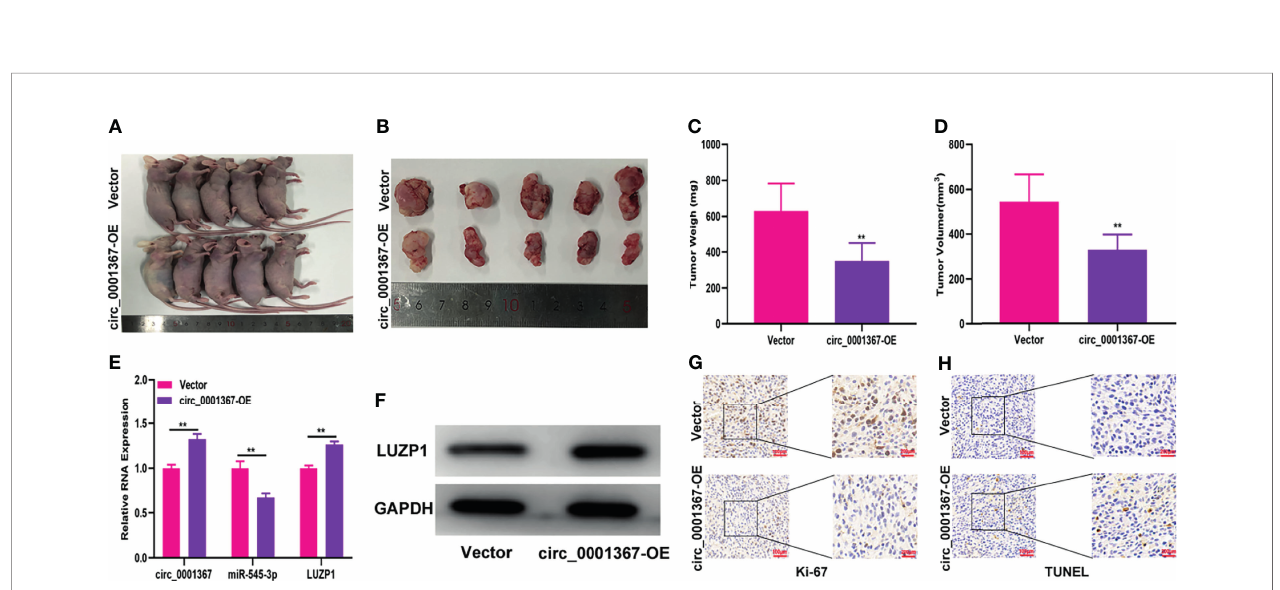
FIGURE 8 | Hsa_circ_0001367 inhibited glioma growth in vivo . (A, B) Tumour formation was examined in nude mice following the implantation of LN229 xenografts with vector or circ_0001367 overexpression. (C, D) The volume and weight of tumours formed in the nude mice. (E) The expression of circ_0001367, miR-545-3p and LUZP1 in the tumours formed in the nude mice was measured by qRT-PCR. (F) The expression of LUZP1 in the tumours formed in the nude mice was measured by western blotting. (G) Immunohistochemistry for Ki-67 in the tumours formed in the nude mice. (H) TUNEL staining of the tumours formed in the nude mice. **P <